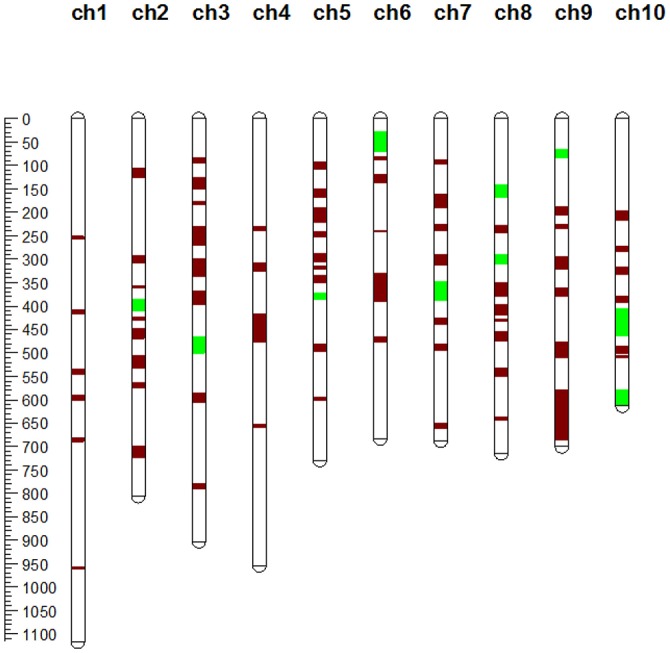
Chromosomal locations of MQTLs identified in this study. The red segments on the chromosome represent MQTLs related to grain yield (GY), ear-related traits (ERT), and kernel-related traits (KRT), while the green segments represent MQTLs related to KRT alone or to GY and KRT simultaneously.